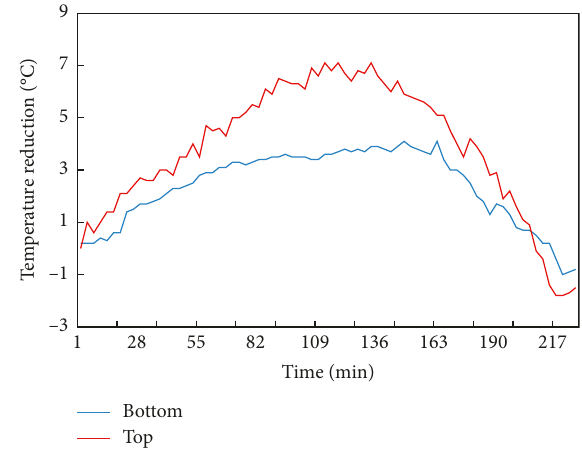
Figure 19: Change in the temperature reduction range on the upper and lower surfaces of the rutting plate samples.